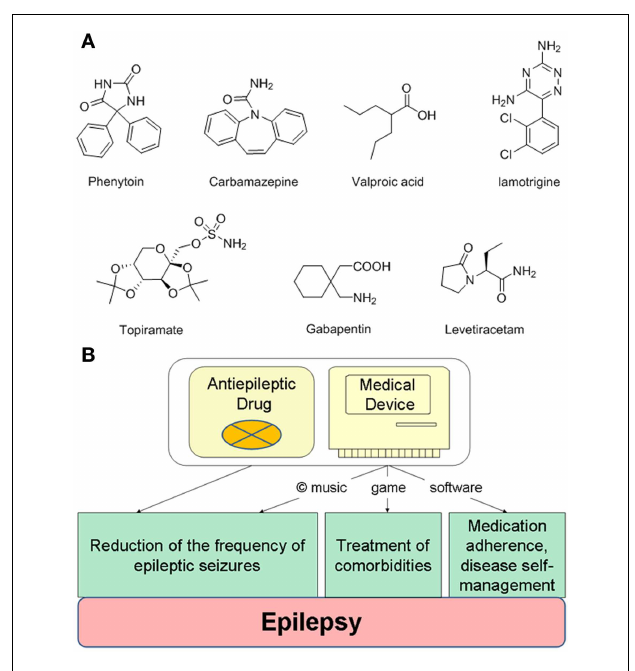
FIGURE 2 | Integrating antiepileptic drugs into a copyrighted combination therapy for the treatment of epilepsy . (A) Examples of generic antiepileptic drugs. (B) Designing an integrated combination therapy consisting of antiepileptic drugs and copyrighted non-pharmacological components delivered by an electronic device.While antiepileptic drugs and music can treat epileptic seizures, a self-management digital platform can include specifically designed games for the treatment of depression or